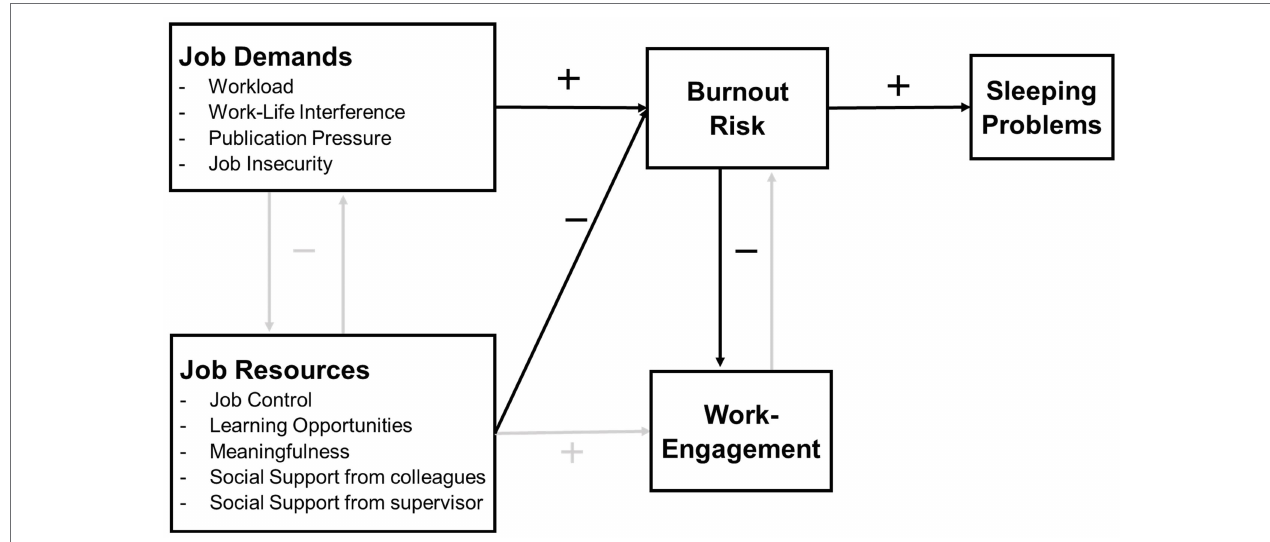
FIGURE 1 | The adapted JD-R model (Schaufeli and Bakker, 2004; Lindblom et al., 2006). This study will focus on the black arrows, the arrows in gray will not be